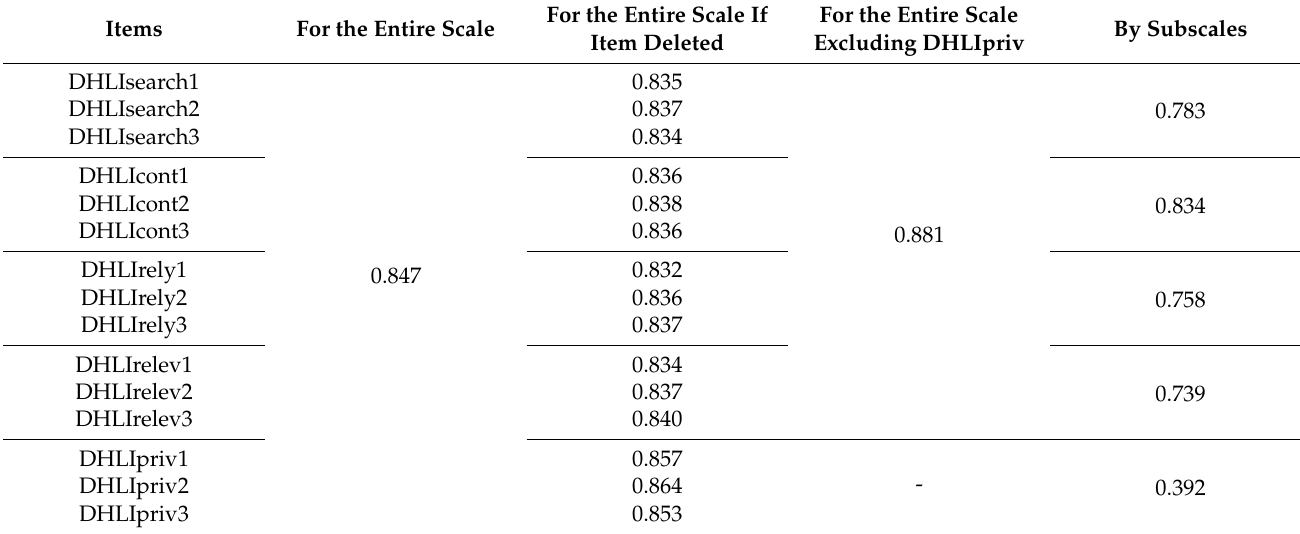
Table 3. Internal consistency of the items: Cronbach’s